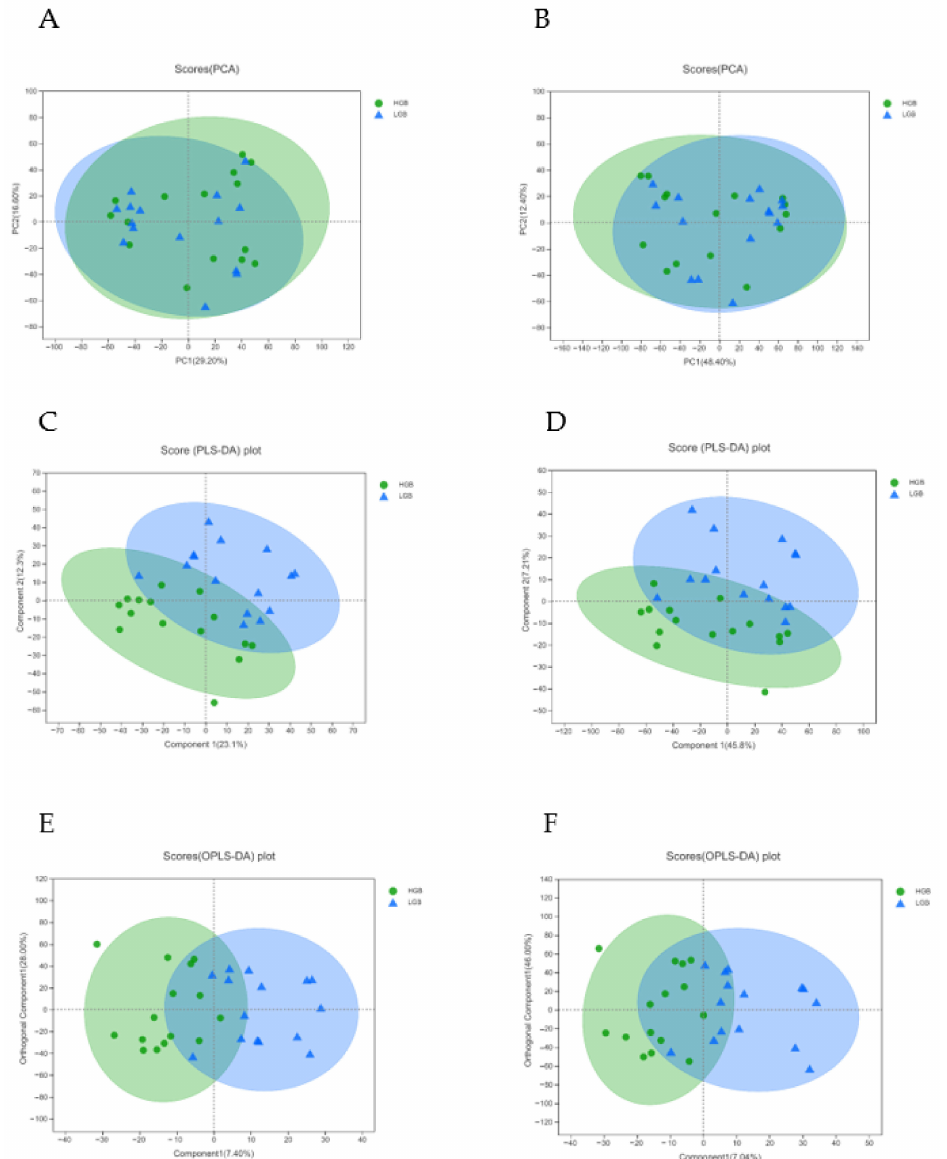
Figure 2. PCA score plots: Principal component analysis of HGB (green) vs. LGB (blue) of positive ( A ) and negative ( B ) using LC-MS data; PLS-DA score plots: partial least squares discrimination analysis of HGB (green) vs. LGB (blue) of positive ( C ) and negative ( D ) using LC-MS data; OPLS-DA score plots: Orthogonal partial least squares discrimination analysis of HGB (green) vs. LGB (blue) of positive ( E ) and negative ( F ) using LC-MS